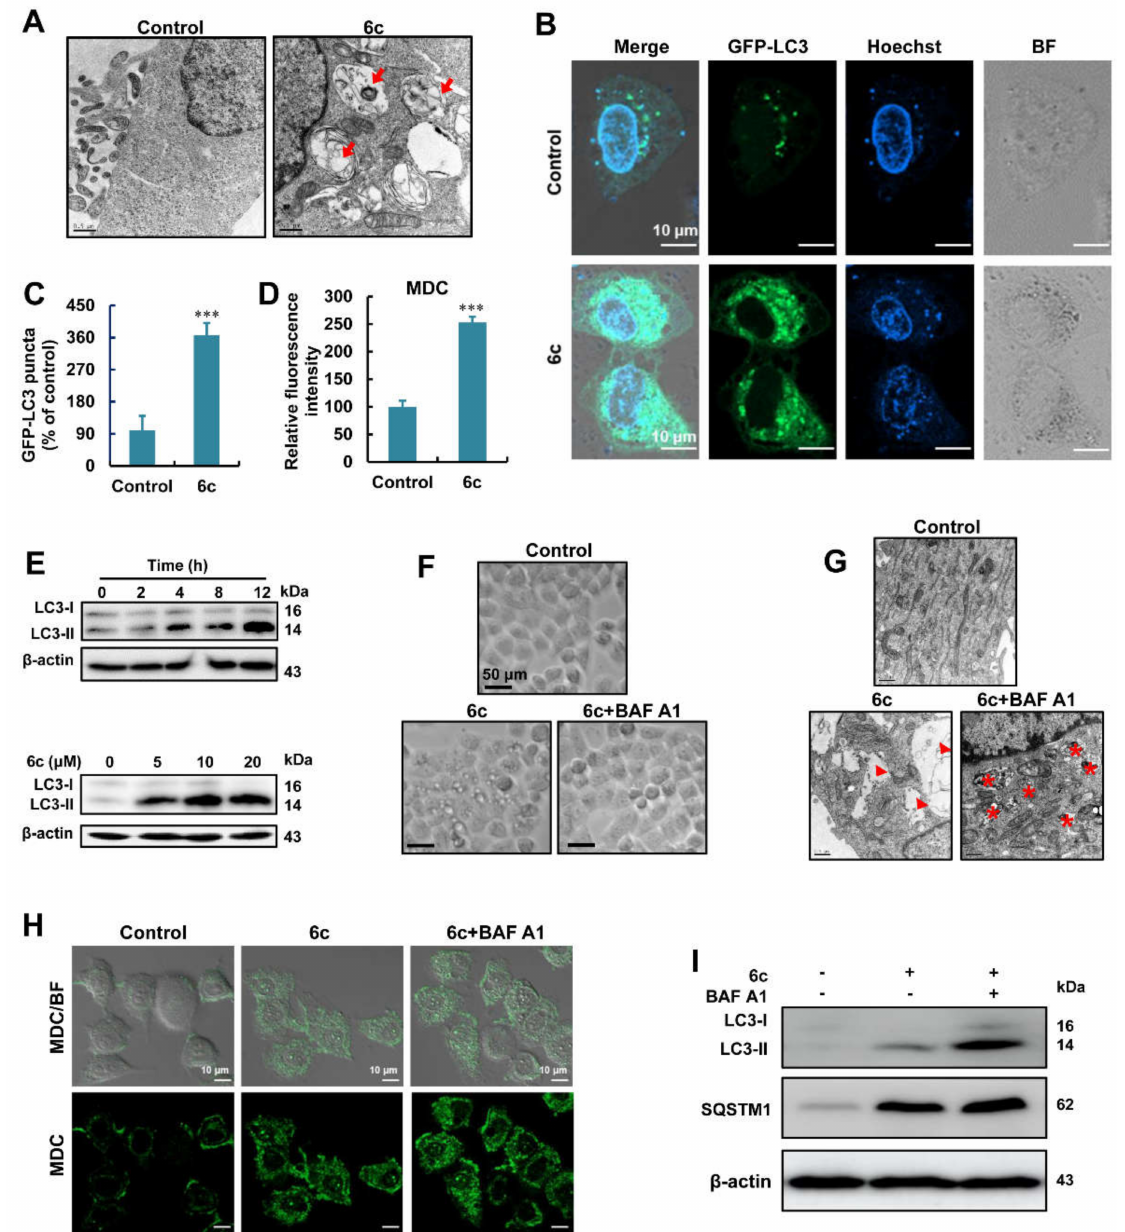
Figure 2. Compound 6c induced autophagosome formation. ( A ) TEM images of HepG2 cells treated with or without 6c for 6 h. ( B , C ) Images and statistical results of GFP-LC3 puncta in HepG2 cells treated with 6c ( n = 25). ( D ) Statistical results of MDC staining in 6c-treated HepG2 cells. Cells exposed to 6c for 6 h were stained with MDC and then detected using HCS ( n = 3). ( E ) Expression of LC3 in HepG2 cells treated with 6c at different time (up) or treated with various concentrations of 6c (down) for 24 h. ( F ) Pre-treatment with BAF A1 reduced the cytoplasmic vacuolations in HepG2 cells exposed to 6c for 6 h. ( G ) TEM images showed that BAF A1 (50 nM) pre-treatment for 1 h delayed the occurrences of cytoplasmic vacuolations induced by 6c for 6 h. ( H ) Images of MDC staining in BAF A1-treated HepG2 cells. Cells were exposed to BAF A1 for 1 h followed by 6c (20 µ M) treatment for 6 h. ( I ) Expression of LC3 and SQSTM1 in HepG2 cells. Cells were exposed to BAF A1 for 1 h followed by 6c (20 µ M) treatment for 24 h. *** p < 0.001 versus